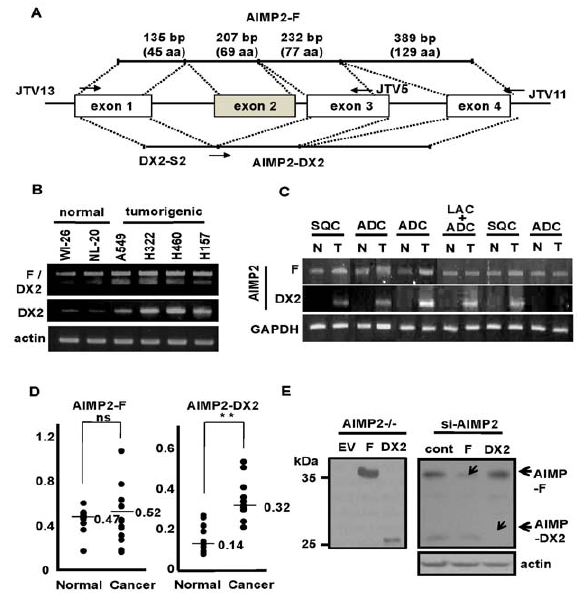
Figure 1. Generation of AIMP2 splicing variant lacking exon 2. (A) The AIMP2/p38 structural gene consists of four exons encoding a total of 320 aa (NM_006303) with three introns. The 312 aa version of AIMP2 is also reported as U24169. Both forms appear to work similarly for most of our experiments although we do not know the reason for the existence of the two forms at this point. The sequences of exon 1, 2 and 3, and the primers, JTV13, JTV5, JTV11 and DX2-S2 are shown in Figure S1. (B) Expression of AIMP2-F and –DX2 was examined in different lung cells (Normal: WI-26, NL-20; tumorigenic: A549, H322, H460 and H157) by RT-PCR using their specific primers shown above. The pair of the primers, JTV13 and JTV11, generates the two PCR products, one from the transcript of AIMP2-full length (upper band)